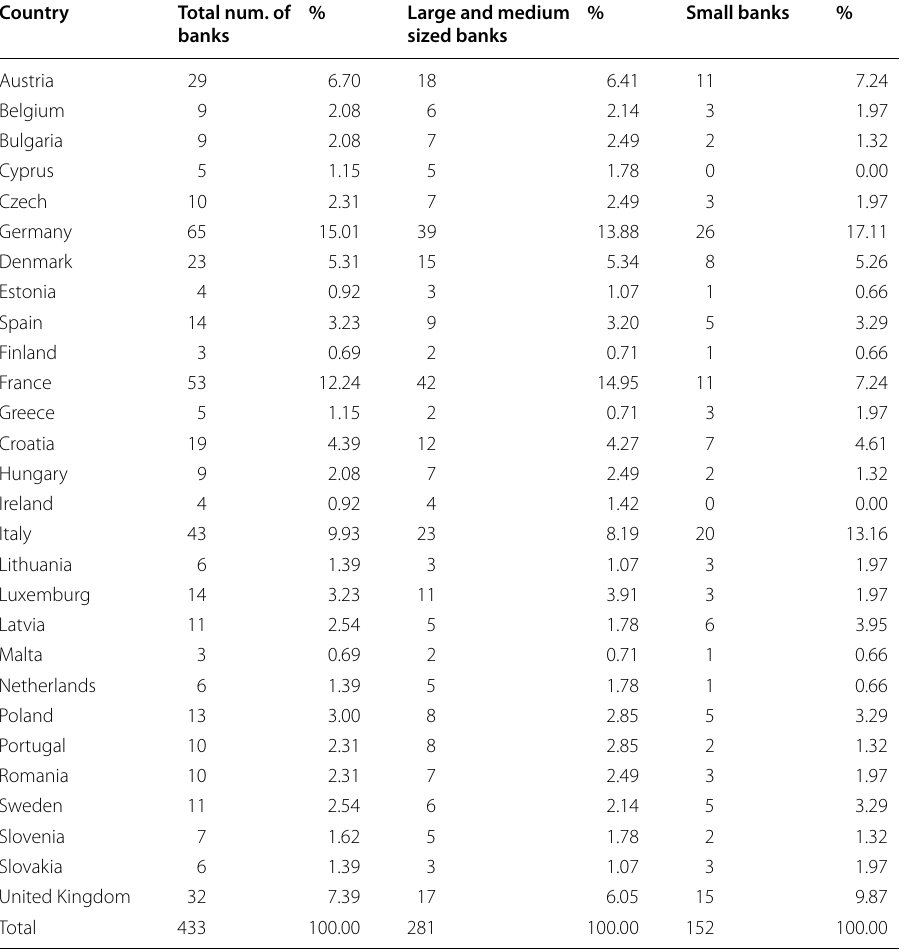
Table 2 Distribution of banks according to the country of origin and bank